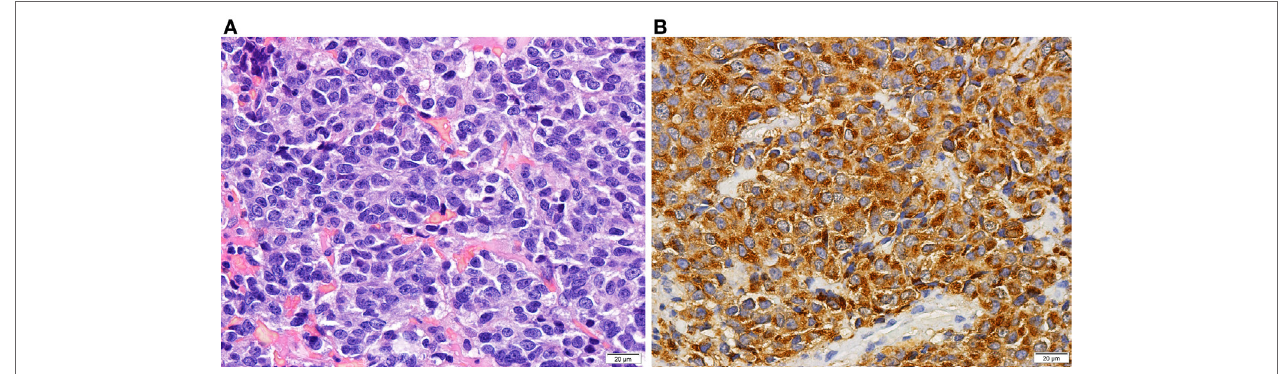
FIGURe 2 | Histology of a prolactin-producing pituitary tumor. Tumor with diffuse growth pattern of cells with elongated nuclei and inconspicuous nucleoli and moderate amount of slightly acidophilic cytoplasm [ (a) —HE 400 × ]. Prolactin expression in neoplastic cells [ (B) —400 ×